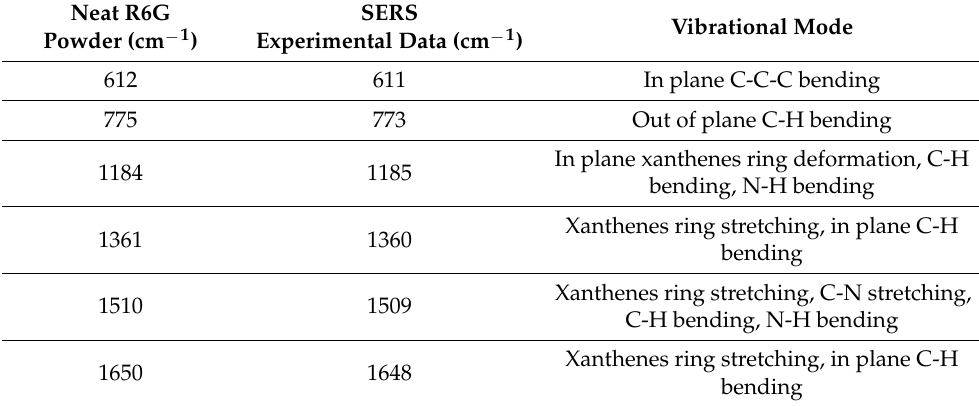
Figure 6. ( a 1 , a 2 ) Raman spectra of R6G powder and neat C fiber; ( b ) Raman spectra of 10 −6 M R6G on different Ag x -C-fiber substrates; ( c 1 , c 2 ) the Raman spectra of 10 −6 M R6G on Ag 30 -C-fiber and Ag 15 - on different Ag x -C-fiber substrates; ( c 1 , c 2 ) the Raman spectra of 10 − 6 M R6G on Ag 30 -C-fiber and C-fiber substrates consistent with Figure 6b. Ag 15 -C-fiber substrates consistent with Figure 6b. Table 1. Band assignments of Raman characteristic peaks of